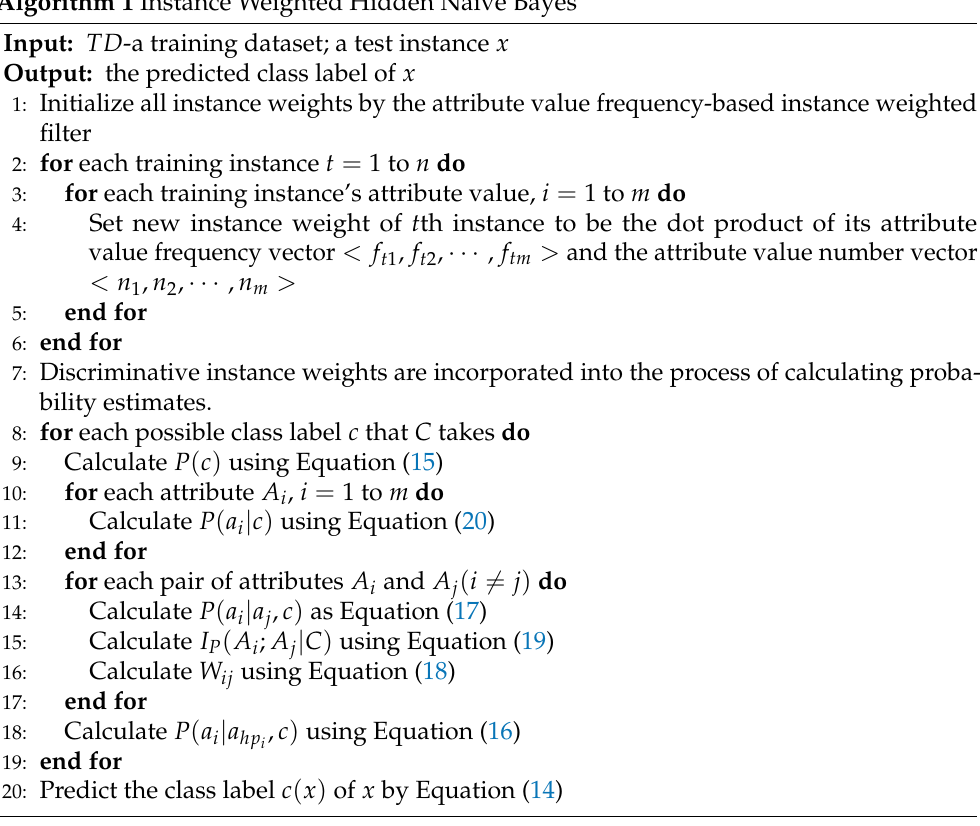
Algorithm 1 Instance Weighted Hidden Naive